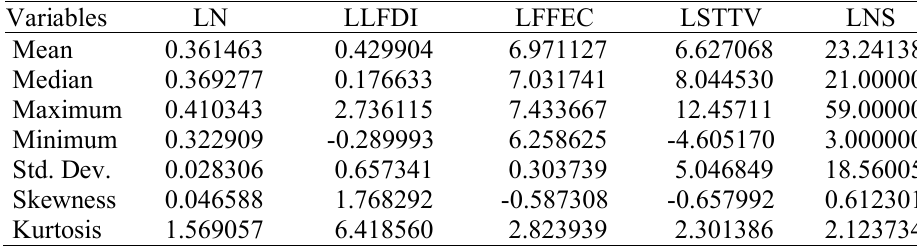
Table 1. Summary statistics.